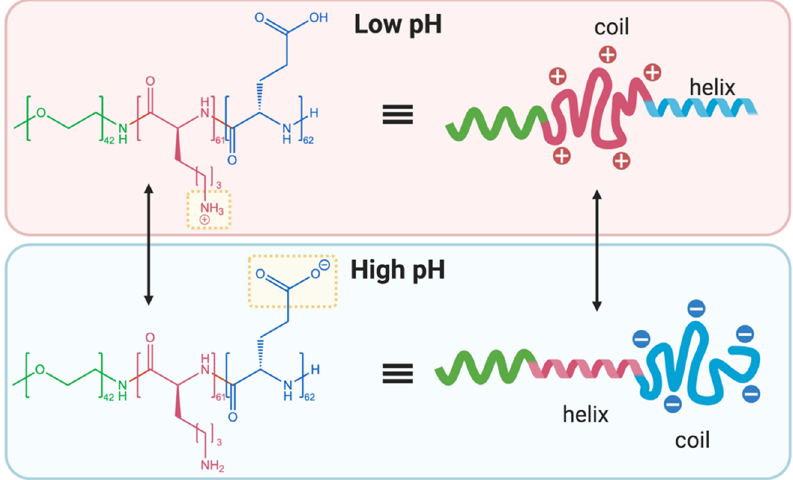
Figure 5. Structure of PEG- b -poly( L -lysine)- b -poly( L -glutamic acid) copolymer prepared by Schlaad and co-workers, showing corresponding changes to secondary conformation at low (1.9–3.1) and high (12.3–13.0) pH values (adapted from [76] ).